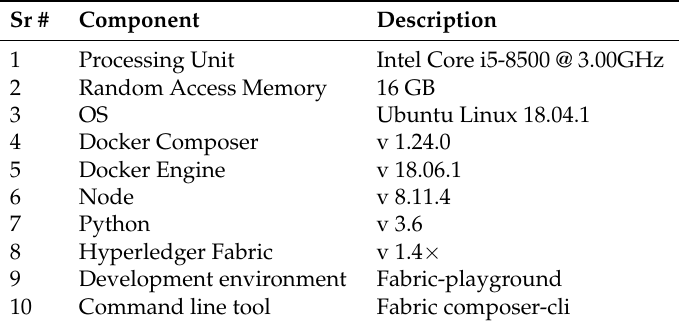
Table 3. EV-blockchain simulation environment.